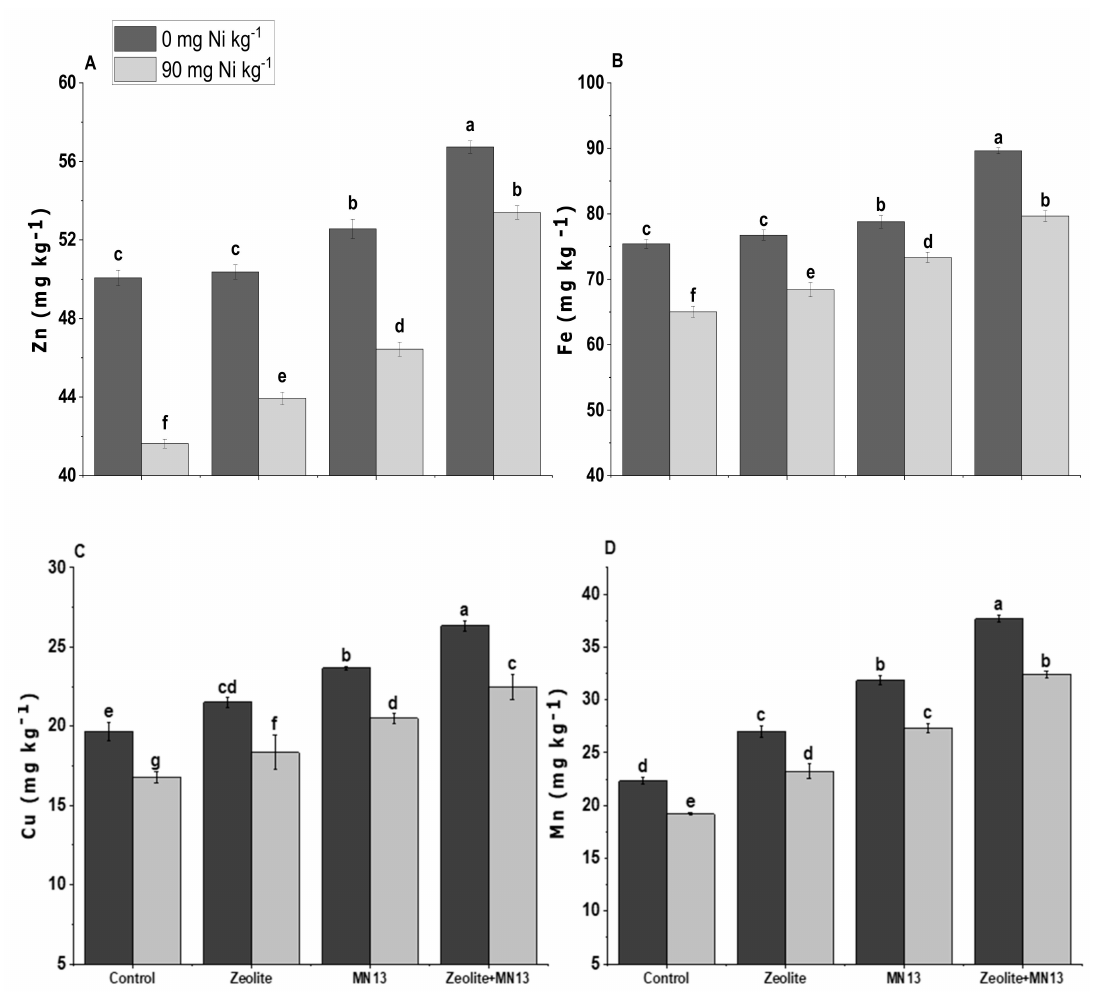
Figure 2. Micronutrients Zn ( A ), Fe ( B ), Cu ( C ), and Mn ( D ) content of sesame shoots by different treatments applied under normal and Ni stressed soil conditions. Values sharing the same letter(s) in bars are statistically non-significant with each other at p < 0.05; the values are mean ± standard error ( n =